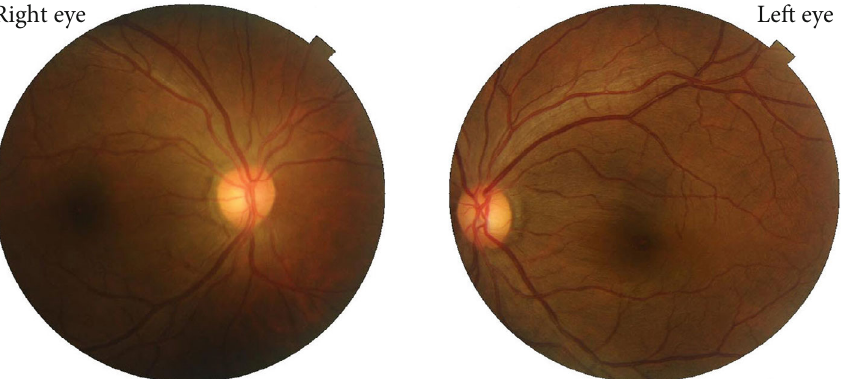
Figure 10: Fundus photography at presentation showing macular lesion simulating macular hole. Bilateral central yellow-white lesion surrounded by orange-brown pigmentation in the macular region is